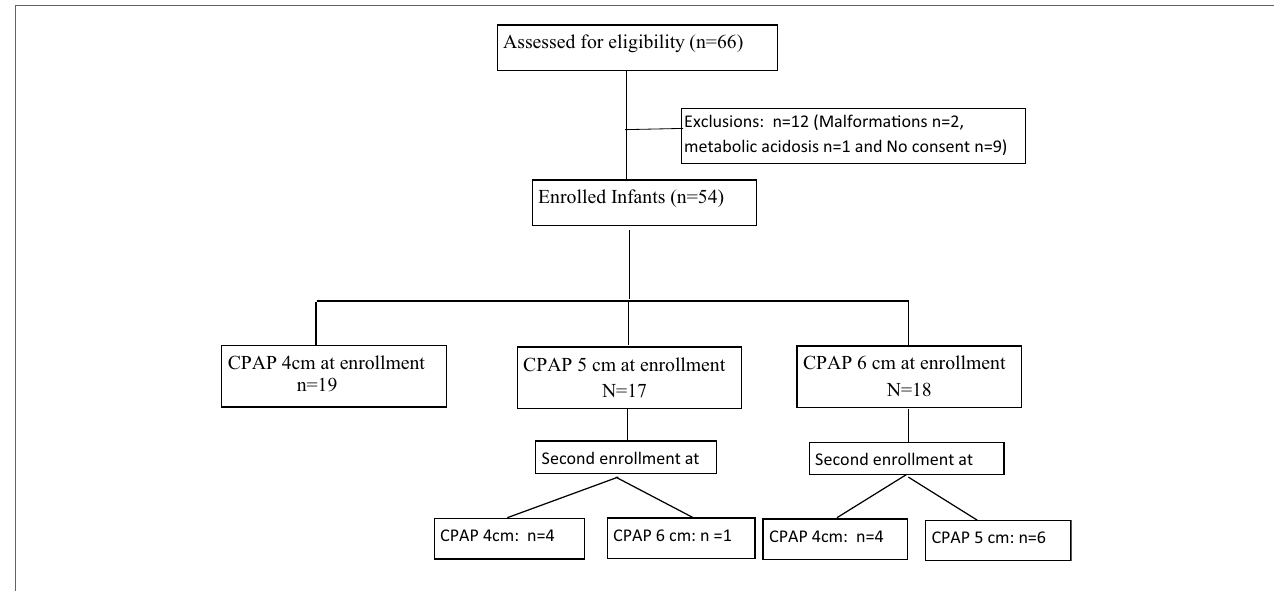
FigUre 1 | Flow of patients in the study .